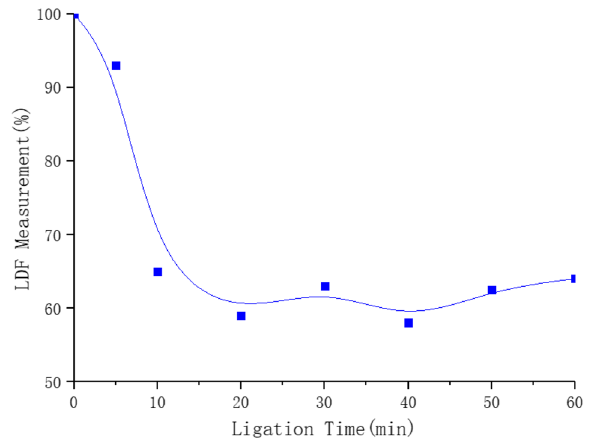
Figure 9. The cerebral blood changes after ligation of the bilateral common carotid